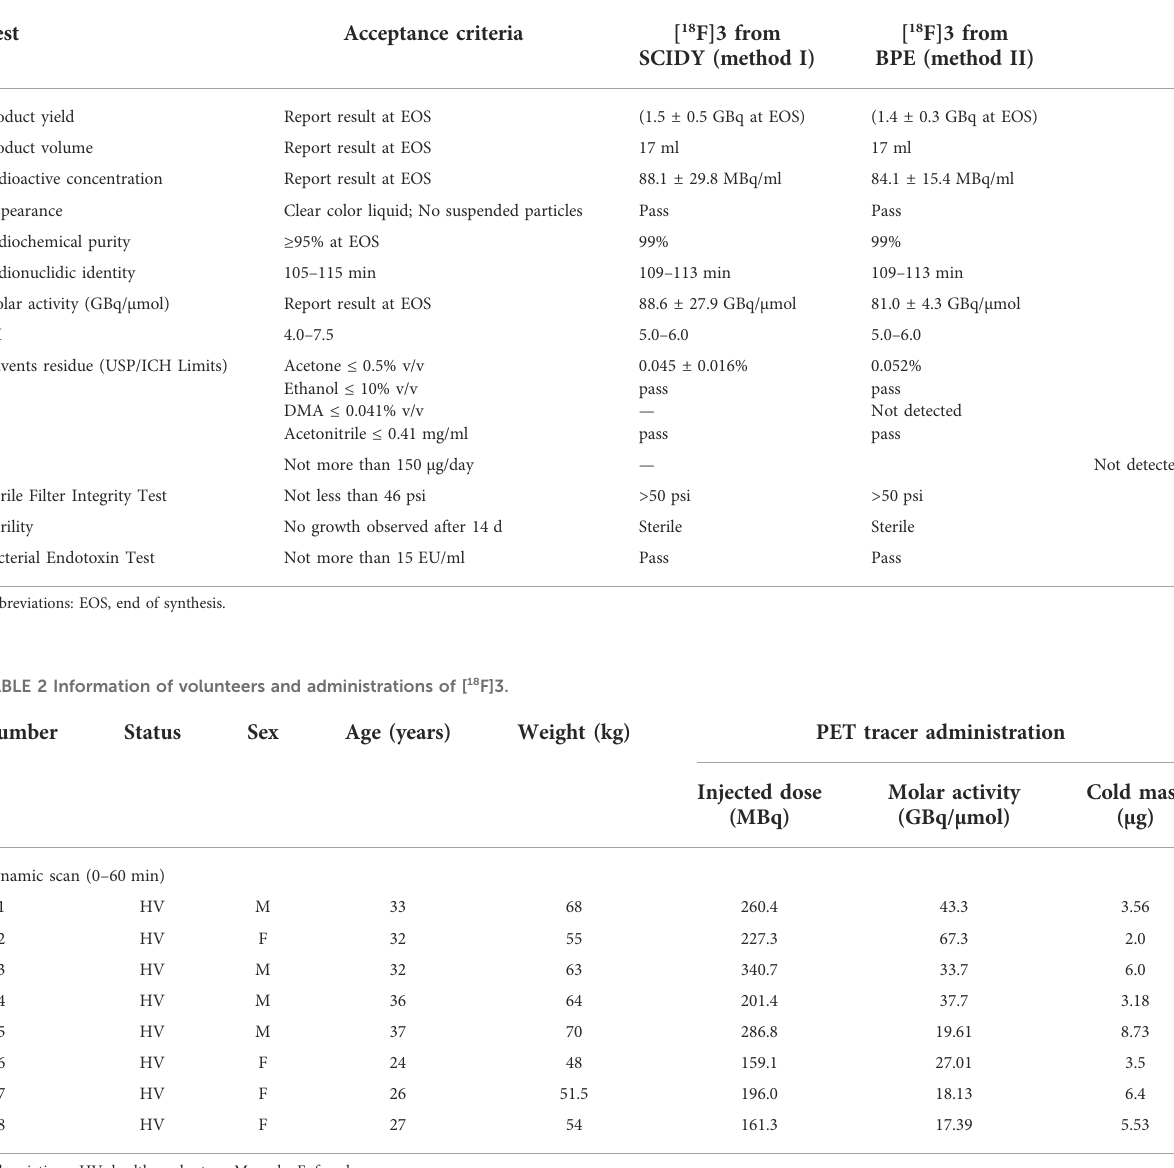
TABLE 1 Summary of [ 18 F]3 human use validation data.